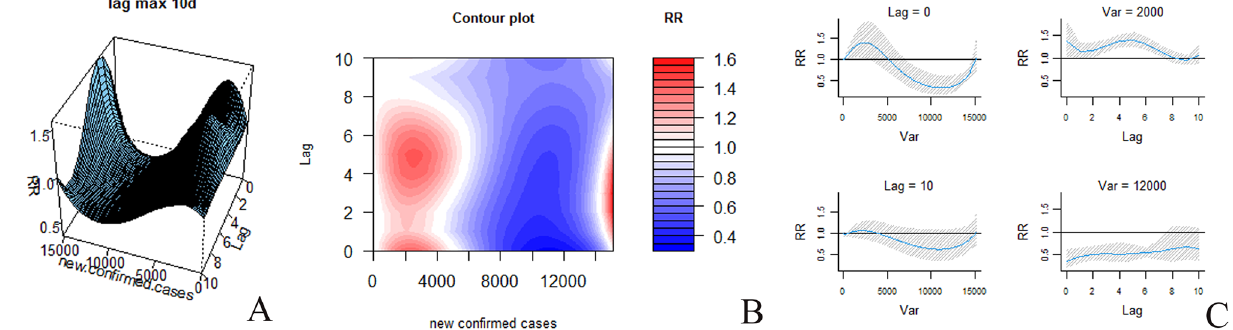
Figure 7. Relationship between the number of newly confirmed COVID-19 cases and fracture risk in China. ( A ) Shows all fractures in three-dimensional graphs, ( B ) shows two-dimensional contour plots, and ( C ) shows two-dimensional graphs for different numbers of lag days and newly confirmed COVID-19